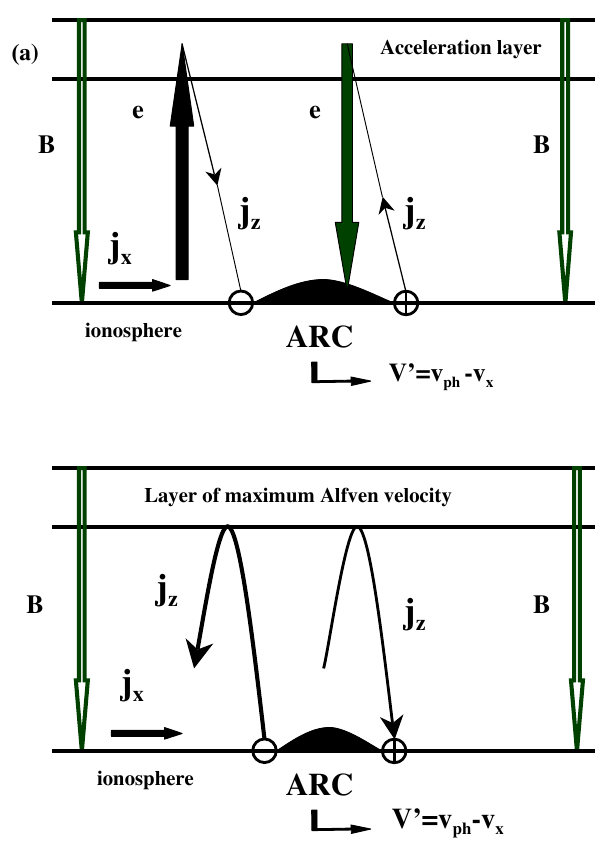
Fig. 1. A scheme explaining the growth of a strip of enhanced ionospheric conductivity, which is thought to be an auroral arc, for two magnetosphere-ionosphere coupling feedback instability mod- els believed to occur in the lower magnetosphere. The instability arises because field-aligned currents j z of an Alfv´en wave emit- ted by the arc-like structure are generated. The first model (a) is based on the modulation of precipitating electrons by field-aligned currents of the upward moving Alfv´en wave (the additional ac- celerated electrons are shown by the symbol “e”). The second model (b) takes into consideration the reflection of the Alfv´en wave from a maximum of the Alfv´en velocity located at altitude of about 3000km. The growth of arc-like structures takes place when the ionization function is shifted from the edges of enhanced conduc- tivity structures to their centers. Such a shift arises when the struc- ture moves along the ionosphere at a velocity v ph , different from the v x = cE y /B drift velocity. As a result, the field-aligned currents of the Alfv´en wave are shifted relatively to the edges of the structures, which leads to a shift of the ionization